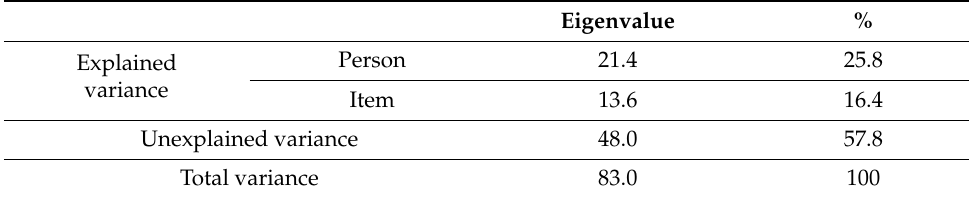
Table 6. Verification of Unidimensionality.